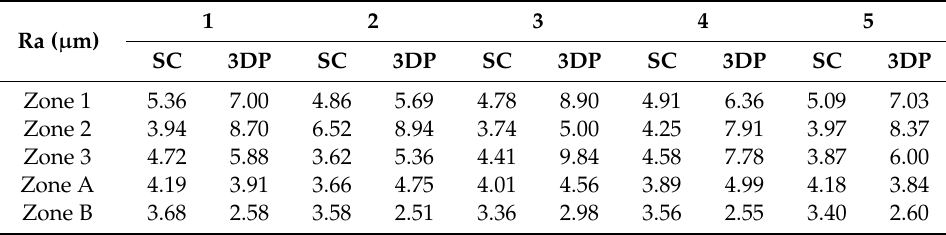
Table 5. Roughness values in the di ff erent areas and